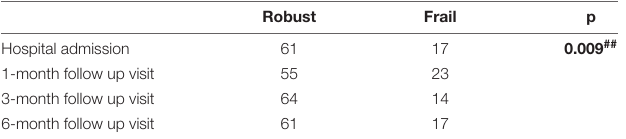
TABLE 8 | Variations of the frailty status during the follow-up in a subgroup of 78 patients.